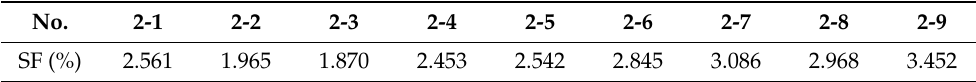
Table 6. The obtained SF values of samples in row 2.